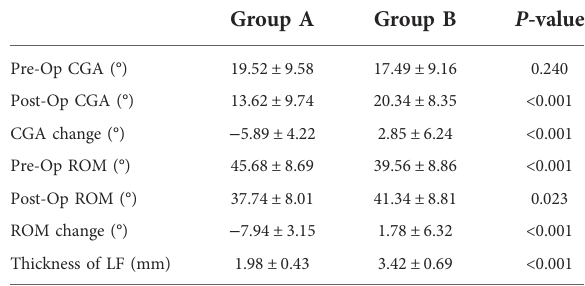
TABLE 2 Comparison of VAS, mJOA and the mJOA recovery rates between Group A and Group B. TABLE 3 Comparison of CGAs, ROMs and ligamentum fl avum thicknesses between Group A and Group